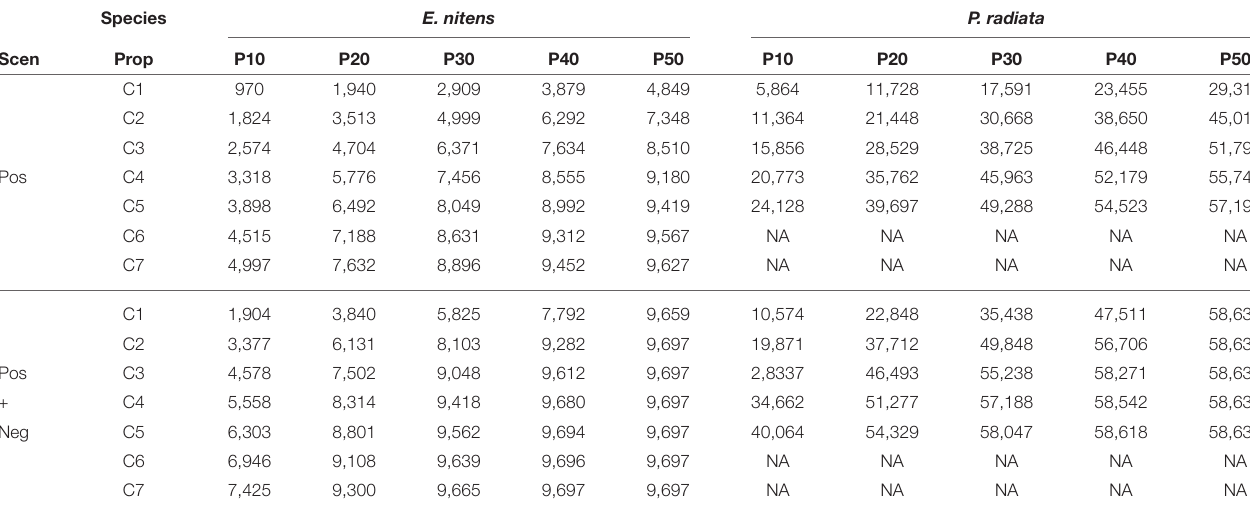
TABLE 2 | Number of markers selected in different scenarios using only positive (upper part) or both positive and negative (bottom part) marker loadings obtained from PLS-CA procedure. Species E. nitens P.